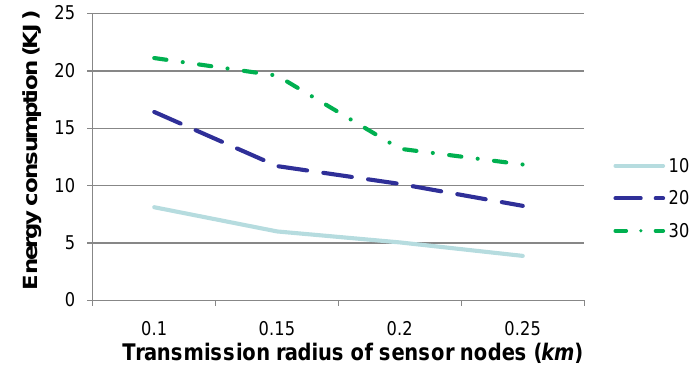
Figure 6. Comparison of energy consumption when the transmission radius r is set to various values. Generally, the larger the value of r is, the less the energy consumption is for sensory data gathering and routing to SN .